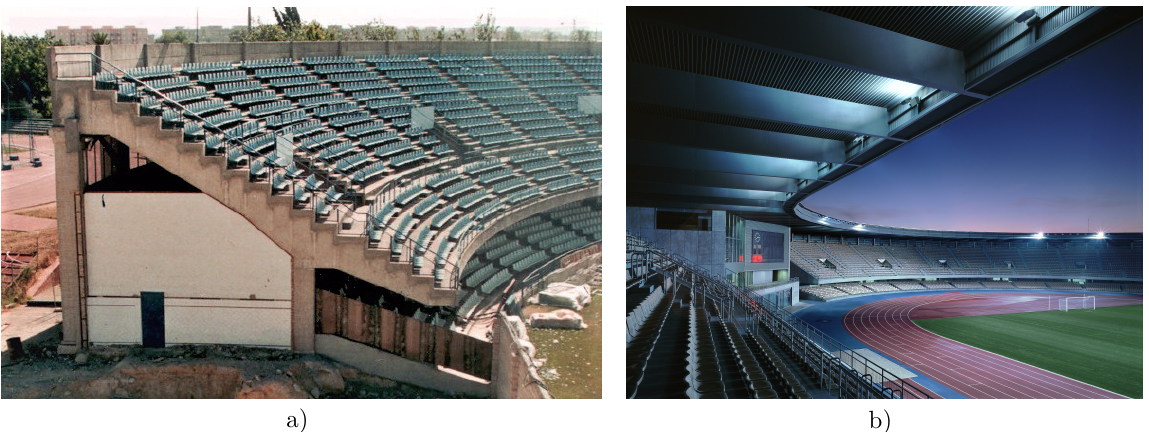
Figure 2. Grandstand of the Chapín stadium: a) as originally built; b) after refurbishment and expansion (courtesy of Cesma Ingenieros and Cruz y Ortiz Arquitectos, © Duccio